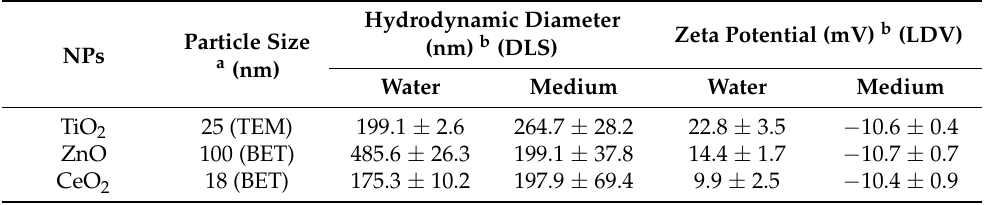
Table 1. Characterization of the NPs used in this study.